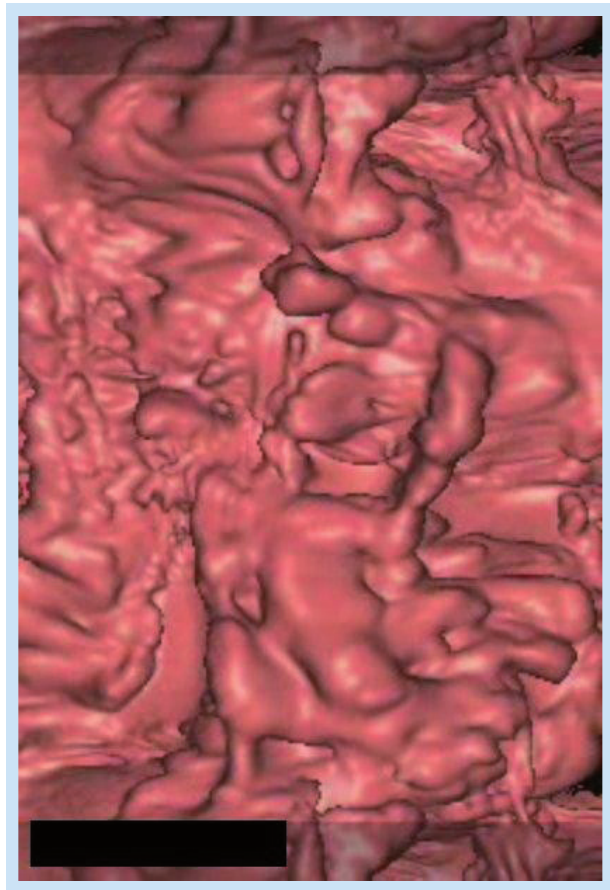
Fig. 8. Appearance due to excessive residual faecal matter.